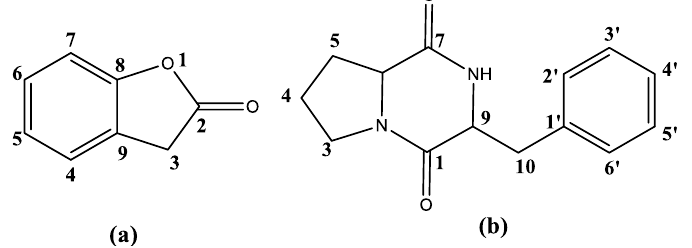
Figure 4. Chemical structures of 2-coumaranone ( a ) and cyclo-(Phe-Pro) ( b ). Compound 2 purified from Fr.5 was a white powder with a relative molecular mass of 224.121, with the chemical formula of C 14 H 16 N 2 O 2 . 1 H NMR (600 MHz, CDCl 3 ): δ 7.22–7.34 (5H, m, H-2, 3, 4, 5 (cid:48) , 6 (cid:48) ), 4.26 (1H, m, H-6), 4.07 (1H, H-9), 3.65, 3.59 (2H, m, H-3), 3.54, 2.78 (2H, m, H-10), 2,33, 1.88 (each 1H, m, H-5), 2.01(2H, m, H-4). 13 C NMR (CDCl 3 ): δ 169.50 (C-7), 165.15 (C-1), 136.01(C-1), 129.38 (C-3 (cid:48) , 5 (cid:48) ), 129.20 (C-2 (cid:48) , 6 (cid:48) ), 127.66 (C-4 (cid:48) ), 59.22 (C-9), 56.28 (C-6), 45.55 (C-3), 36.87 (C-10), 28.44 (C-5), and 22.63 (C-4). According to Table 3. LC 50 values of 2-coumaranone and cyclo-(Phe-Pro) against PWN for 24 h.